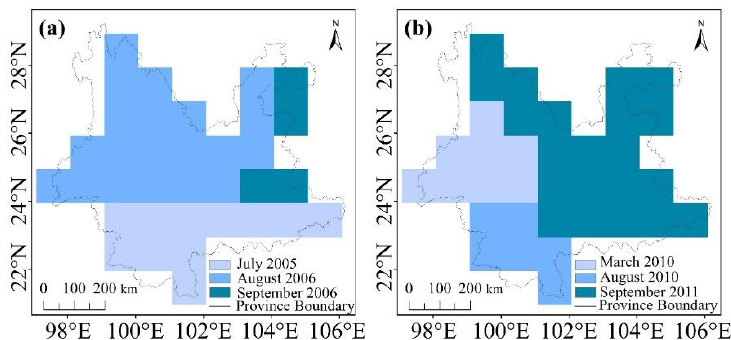
Figure 4. ( a ) Spatial distribution of transition dates from Segment 1 (“first big dry”) to Segment 2 (“big wet”); ( b ) dates from Segment 3 (“second big dry”) to Segment 4 of Total Water Storage